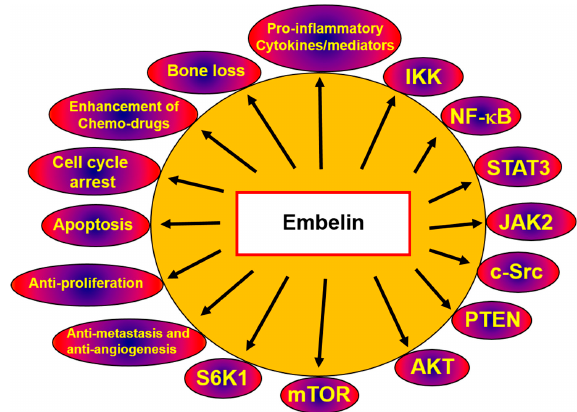
Figure 2. Proposed mechanisms of the potential anticancer activities of embelin.